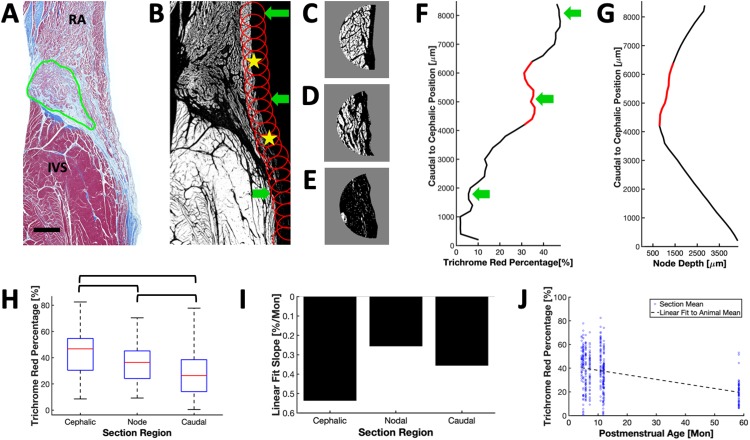
Coverage analyses of AVN.(A) Masson’s trichrome transverse section with outlined compact node. Scale bar: 1 mm. (B) Red threshold image of (A) with representative ROIs plotted at half the original density. Yellow stars indicate borders along the endocardial surface between the nodal, cephalic (top) and caudal (bottom) regions of the endocardial surface. Green arrows indicate ROIs displayed in (C-E). (C-E) Red threshold image in ROI corresponding to the top, middle and bottom green arrow, respectively in (B). Gray areas indicate regions not part of the analysis. (F) AVN coverage of Masson’s trichrome red percentage from each of the circular ROI mapped to the section surface. Green arrows indicate the ROI depicted in (C-E). (G) Depth of node beneath the endocardial surface. Red line segments in (F) and (G) mark the nodal region. (H) Trichrome red percentage for AVN surface regions divided into cephalic, nodal and caudal. Red percentages are different in-between groups (cephalic:nodal P = <0.001, cephalic:caudal P = <0.001, nodal:caudal P = <0.001). (I) Slope from linear regression analysis of trichrome red percentage with respect to age for all animals and sections. Red percentage decreased with age. (J) Linear regression of mean red percentages revealed a decreased myocardial overlay with increasing age (R2 = 0.510; P = 0.047).